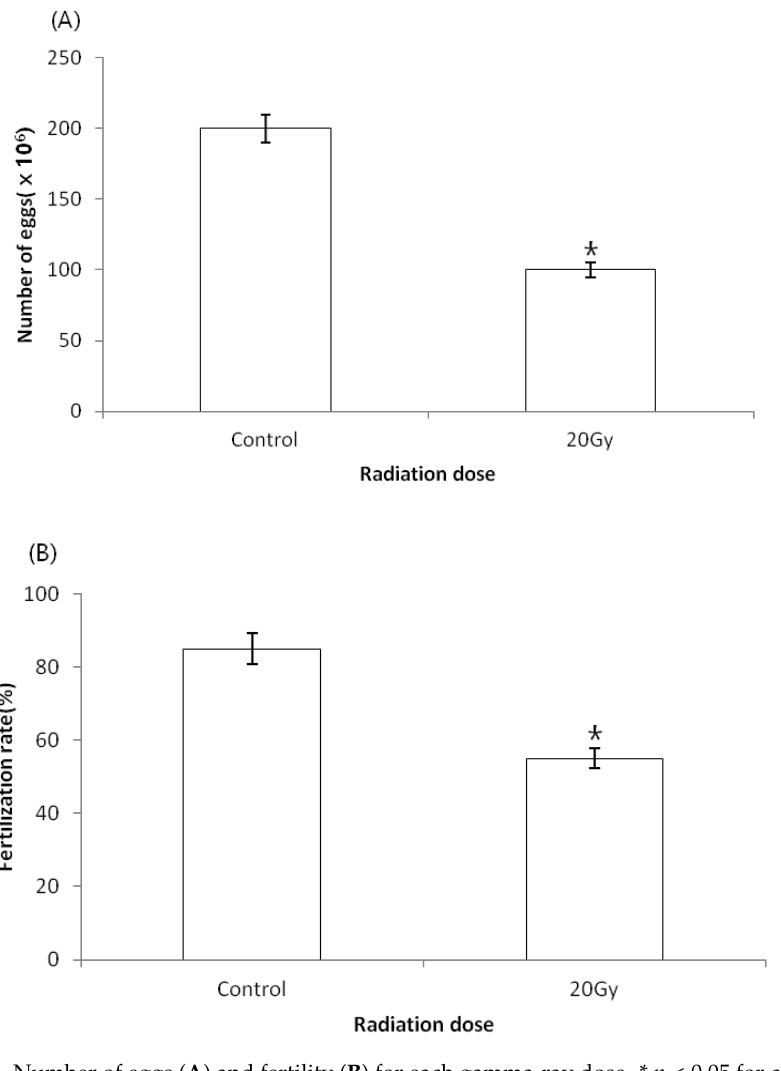
Figure 3. Number of eggs ( A ) and fertility ( B ) for each gamma-ray dose. * p < 0.05 for control.